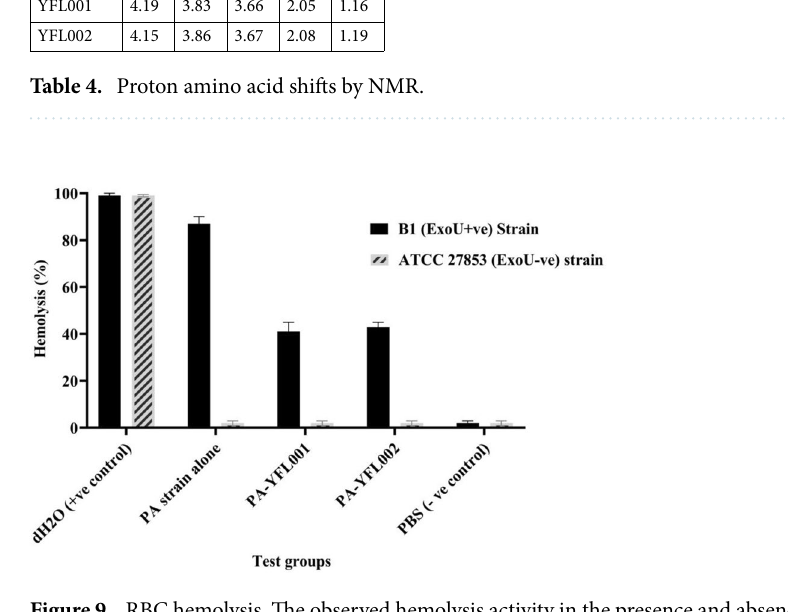
Figure 9. RBC hemolysis. The observed hemolysis activity in the presence and absence of the recombinant proteins was represented as mean (± SD) values.